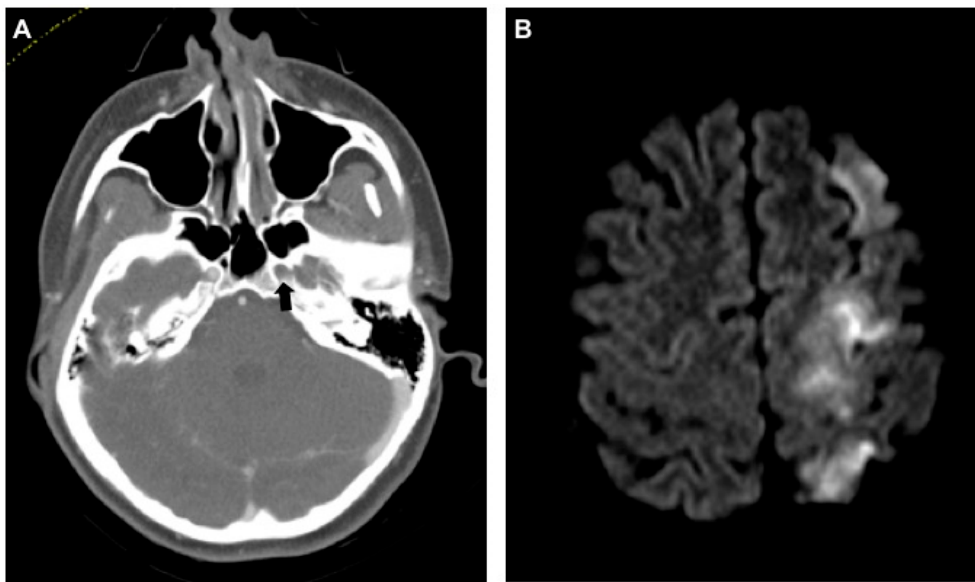
Figure 1. Dissection of the left internal carotid artery (ICA) with severe neurologic sequelae. ( A ) Axial computed tomography angiogram (CT-A) of the skull base shows no contrast agent in the ICA within the foramen carotideum on the left (black arrow). ( B ) Same-day magnetic resonance imaging (MRI) (diffusion weighted imaging (DWI), b800) shows ipsilateral infarction of the anterior and middle cerebral artery territories.